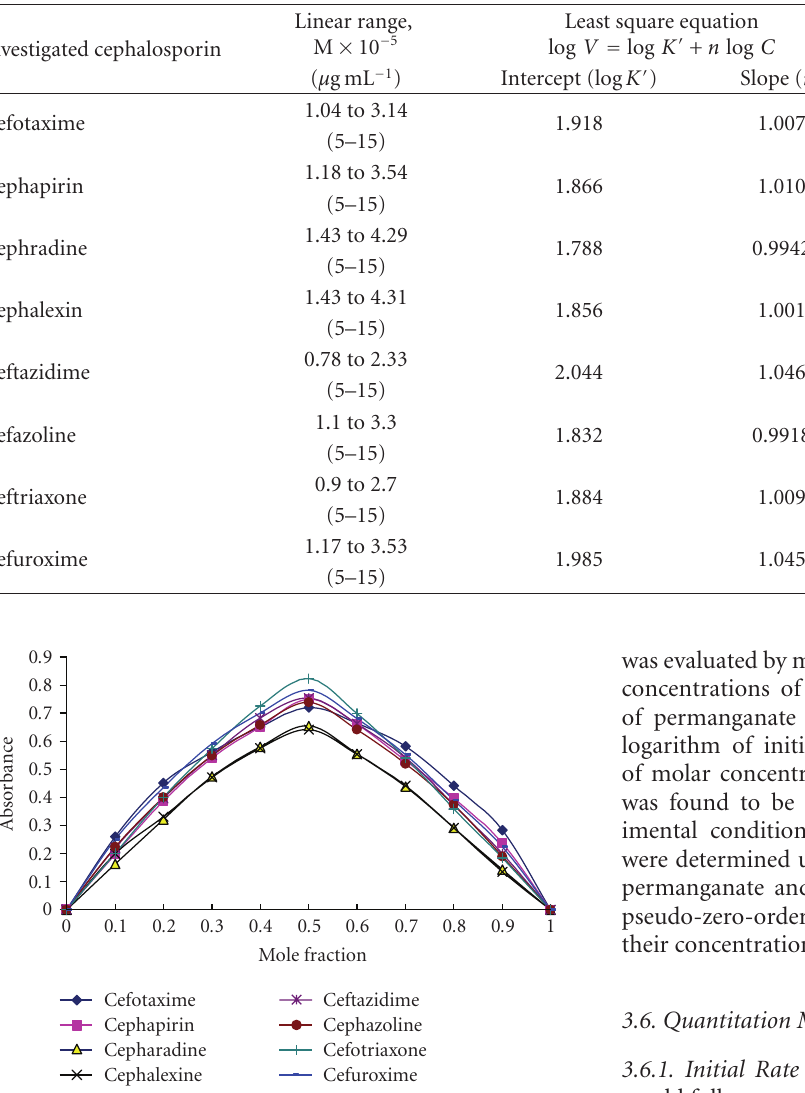
Figure 4: Job’s plots of continuous variation between potassium permanganate and the studied